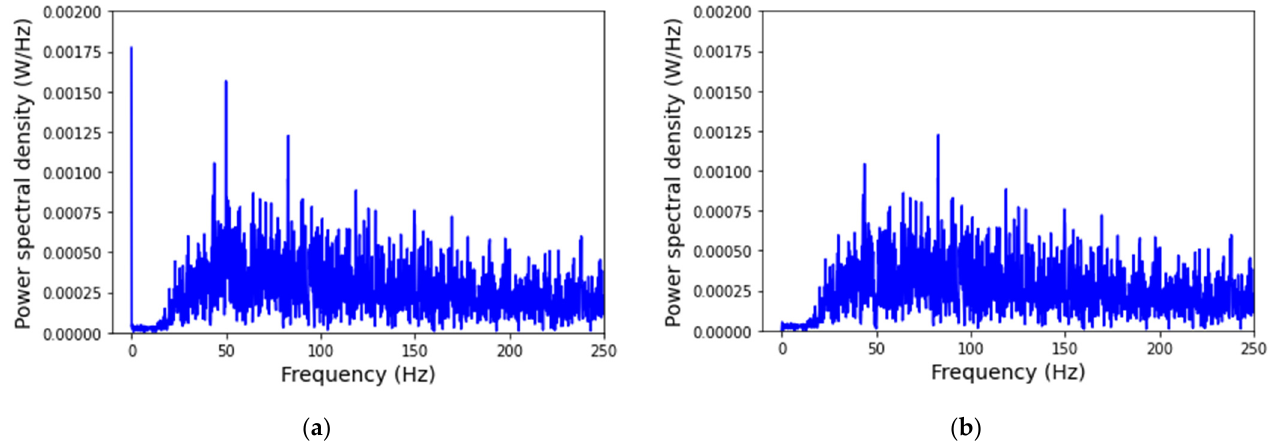
Figure 3. Frequency spectrum of EMG signal ( a ) before and ( b ) after the use of additional